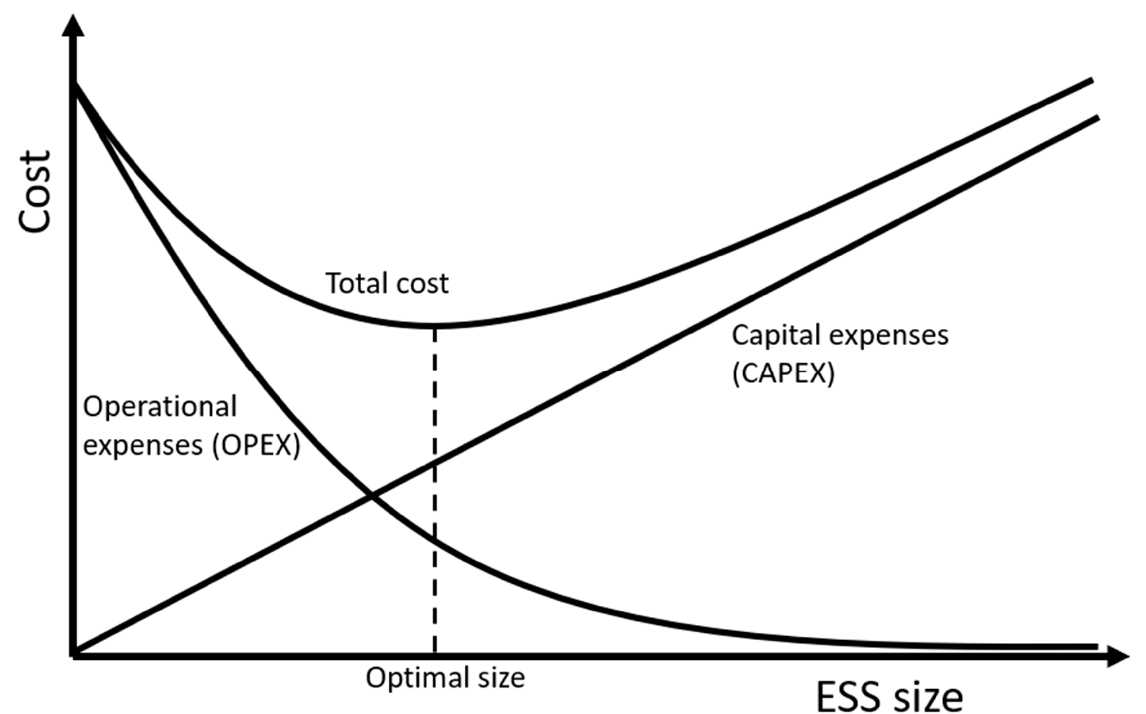
Figure 2. Optimal ESS sizing concept.